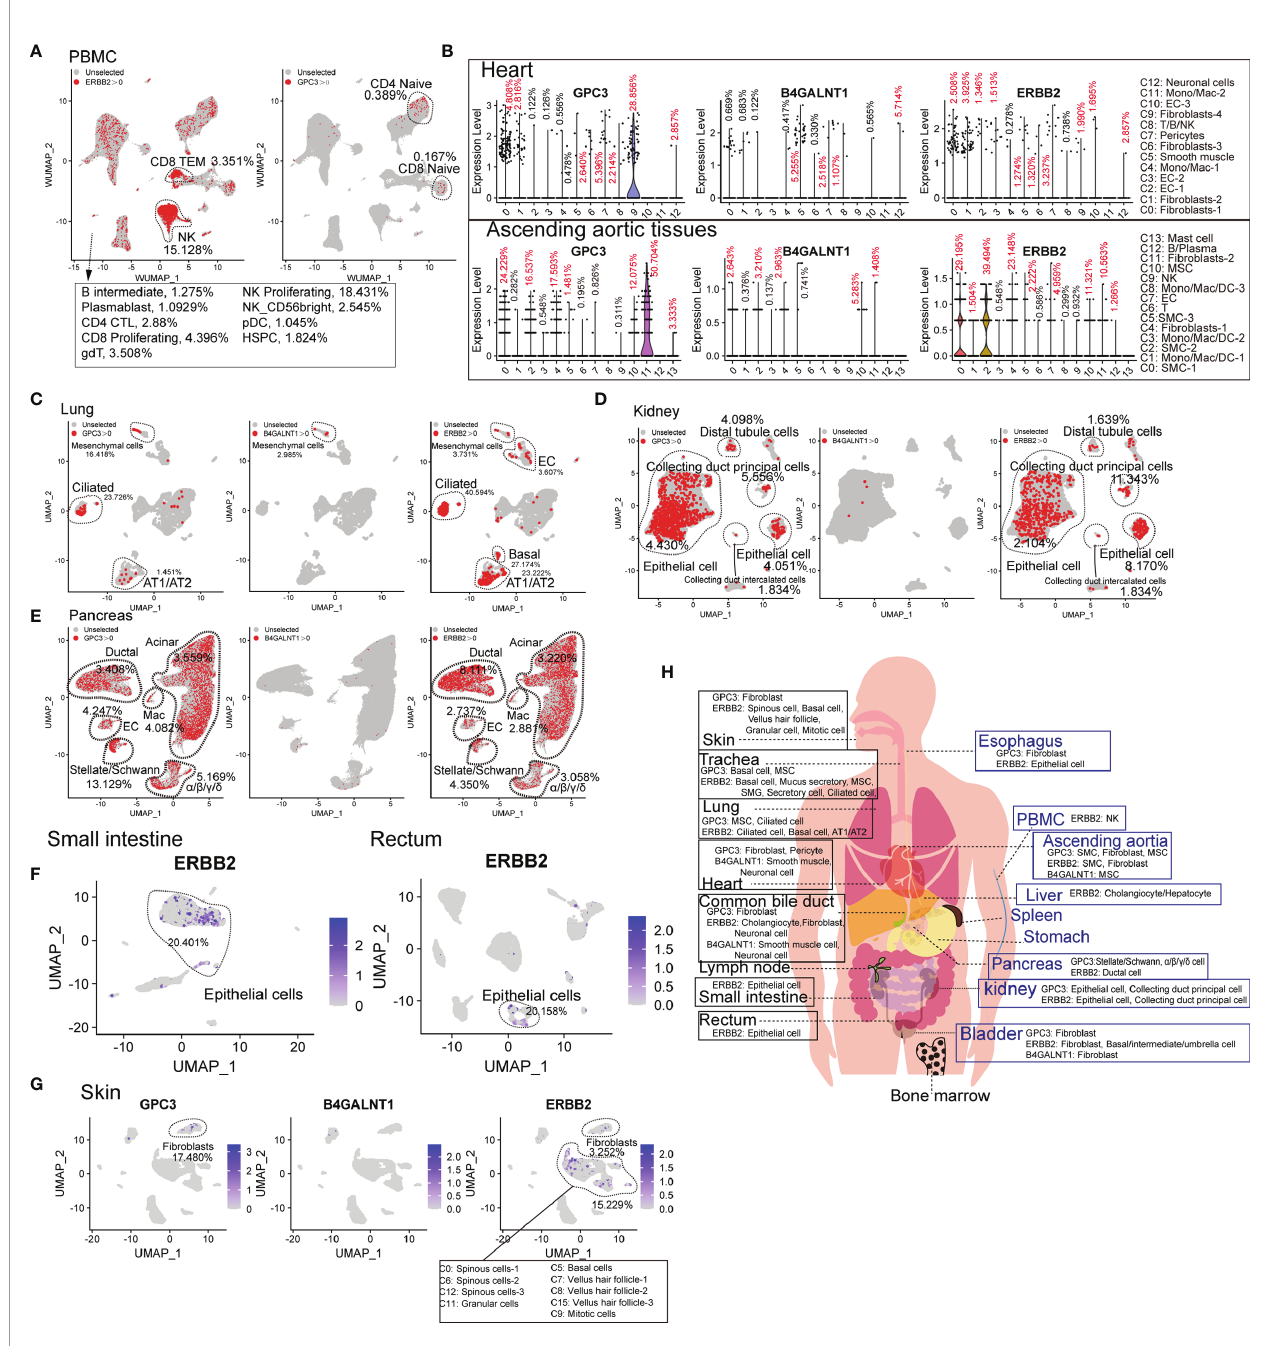
FIGURE 4 | Expression patterns of solid tumor antigens (GPC3, B4GALNT1, and ERBB2) in human normal tissues and organs. (A) GPC3 and ERBB2-expressing proportions (expression value >0) of PBMC-derived cells. (B) Violin plots show the expression levels of GPC3, B4GALNT1, and ERBB2 in heart-derived clusters and ascending aortic tissue-derived cells. GPC3, B4GALNT1, and ERBB2-expressing proportions (expression value >0) of lung-derived cells (C) , kidney-derived cells (D) , and pancreas-derived cells (E) . (F) UMAP plots show the expression level of ERBB2 in small intestine-derived cells and rectum-derived cells. (G) UMAP plots show the expression levels of GPC3, B4GALNT1, and ERBB2, in skin-derived clusters. (H) Schematic diagram of high GPC3/B4GALNT1/ERBB2-expressing cell types in different tissues and